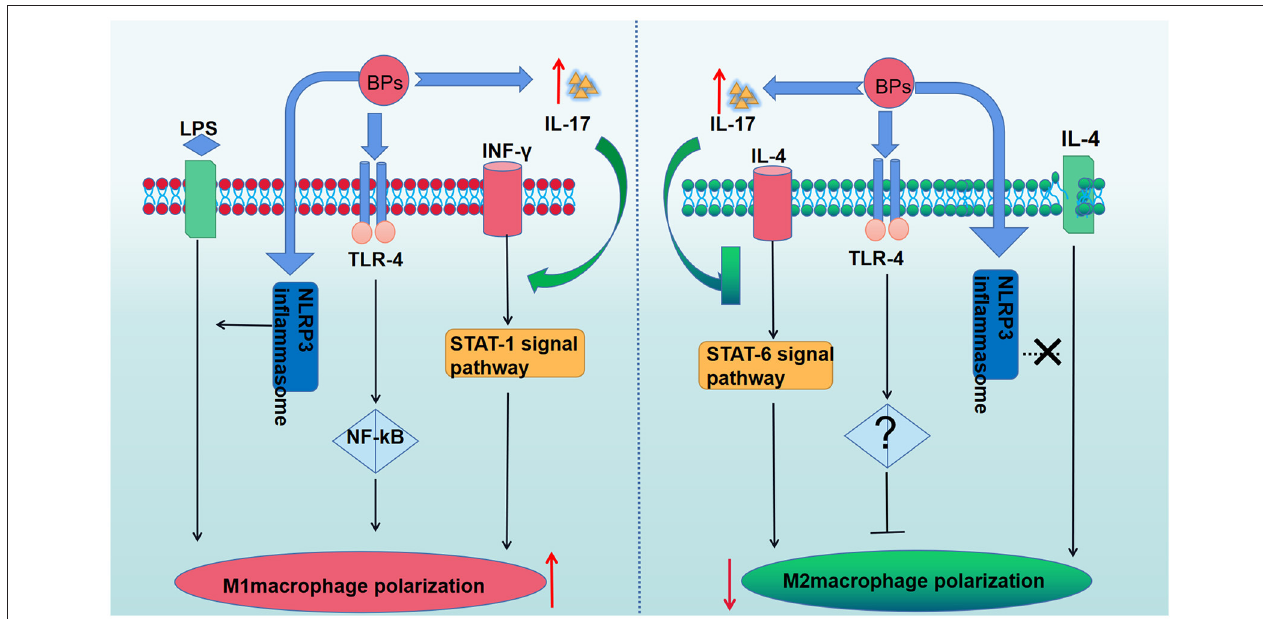
FIGURE 2 | The role of BPs in the macrophage polarization. BPs increase M1 macrophages polarization by activating the TLR-4 signaling pathway and its downstream NF- κ B signaling pathway. The polarization of M2 macrophages was suppressed due to the activation of the TLR-4 signaling pathway. BPs enhance LPS-induced M1 macrophages through NLRP3 inflammasome activation but have no effect on the differentiation of M2 macrophages in IL-4-treated human macrophages. The enhanced IL-17 can promote the polarization of M1 macrophages by activation of the STAT-1 signal pathway but inhibit M2 macrophages polarization by affecting IL-4-mediated activation of the STAT-6 signal